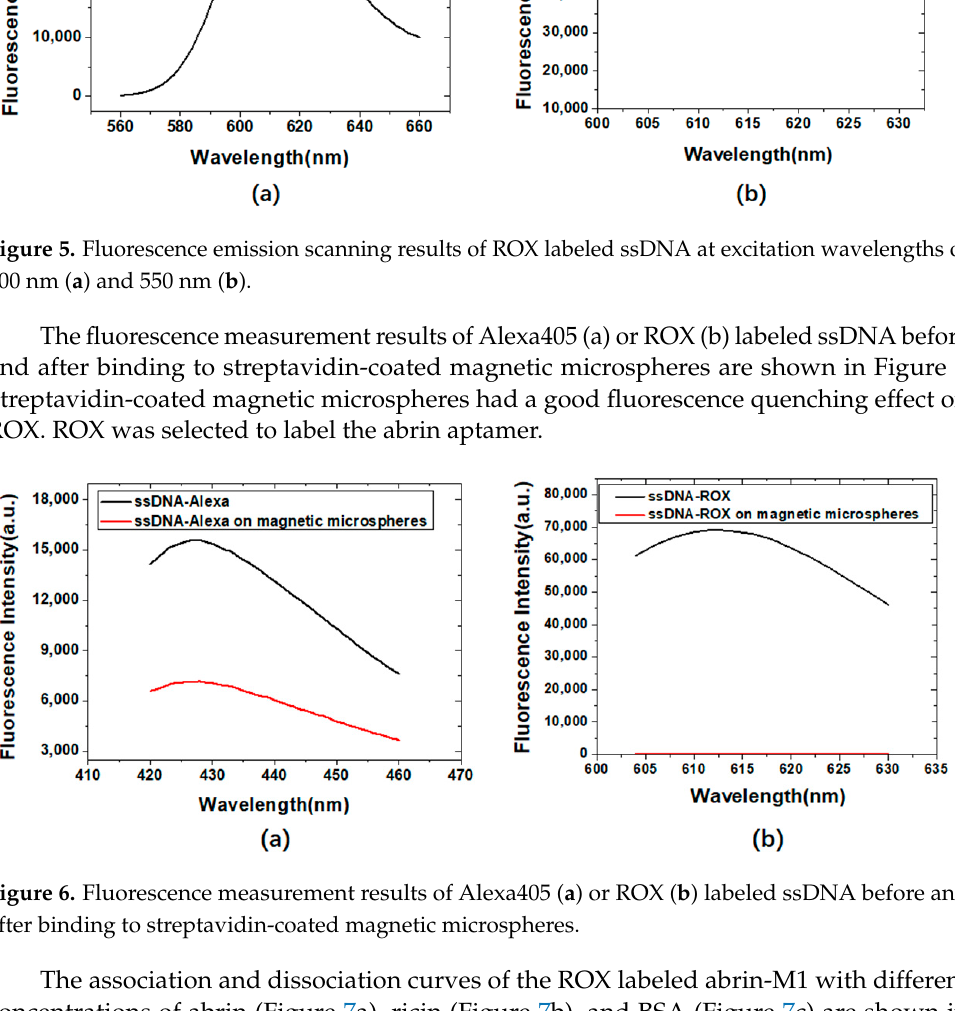
after binding to streptavidin-coated magnetic microspheres.